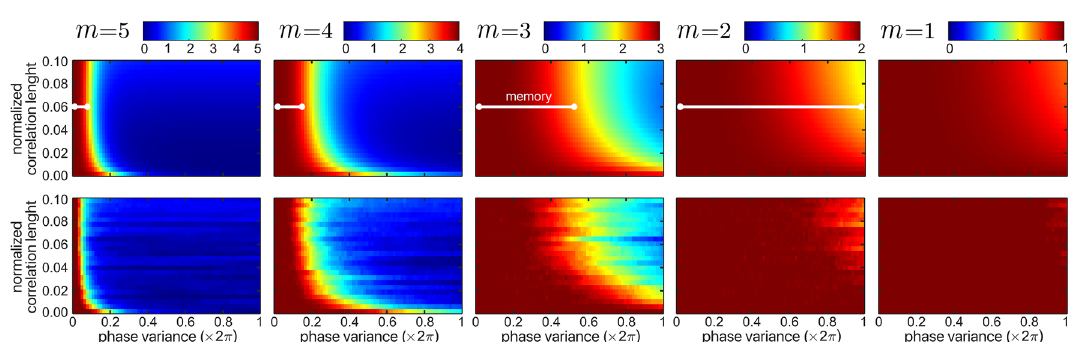
Figure 1. Analytical (top row) and numerical (bottom row) illustration of the phase memory in optical vortex beams. The color scale represents the vorticity evaluated over a circular contour of radius ρ 0